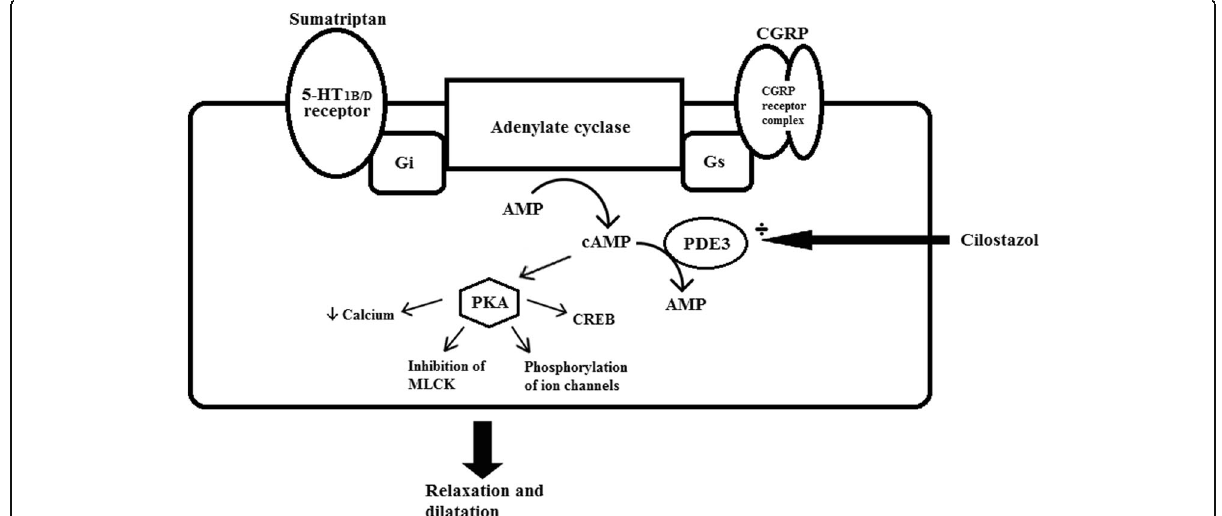
Fig. 6 The intracellular mechanisms in a smooth muscle cell after sumatriptan, cilostazol and calcitonin gene related peptide (CGRP) administration. Sumatriptan acts on 5HT1B/D receptors coupled to Gi receptors. This leads to an inhibition of adenylate cyclase and consequently a decrease in cAMP. Cilostazol inhibits PDE3 and thus cause intracellular cAMP accumulation. cAMP activates PKA which leads to a number of intracellular changes and in the end a relaxation and dilatation of the